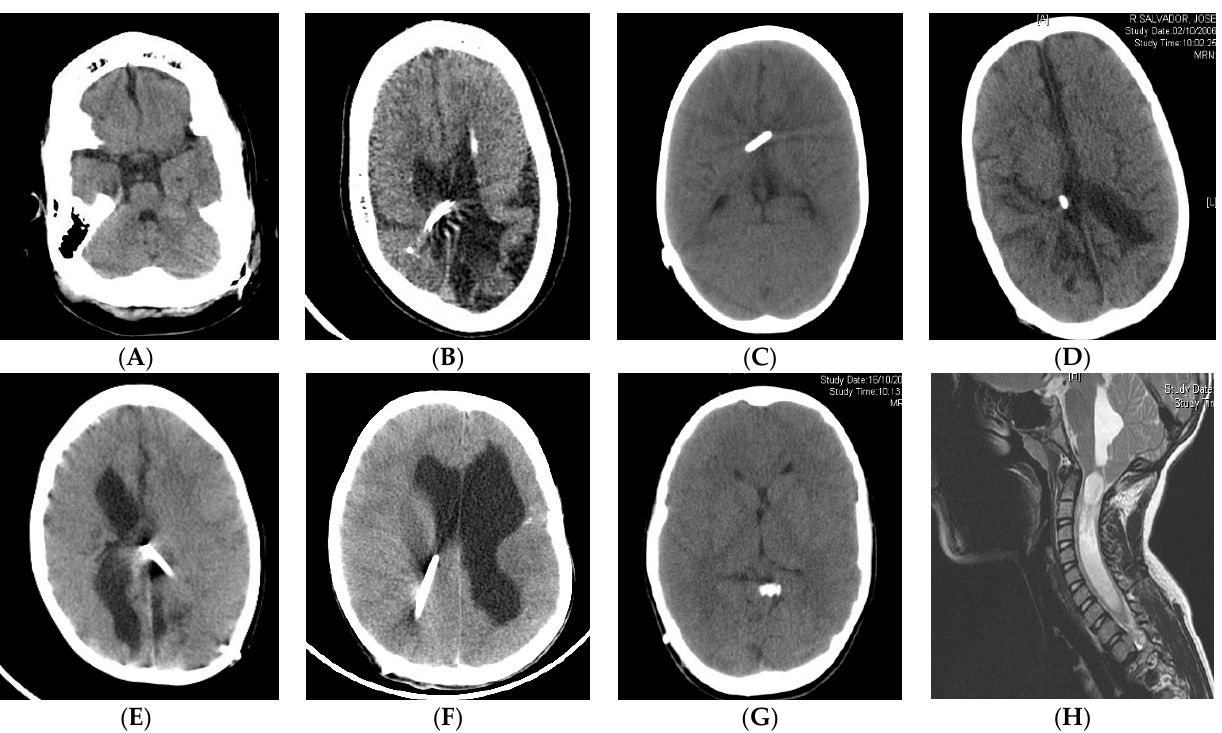
Figure 1. ( A , B ) A 5-year-old patient, shunted at birth after posthemorrhagic hydrocephalus. Postural symptoms. White matter damage with brain atrophy, small non-collapsed ventricles, extra-axial fluid collections, widened brain sulci, calcifications, laminated thickening of the calvarium, dolichocephaly and sinus hyperpneumatization. Shunt exchange with GV implantation was carried out, followed by clinical improvement. ( C ) An 8-year-old, shunted at birth after posthemorrhagic hydrocephalus. Complete ventricular collapse. Clinically, the patient presented sustained intracranial hypertension with papilledema, altered consciousness and bradycardia. Symptoms improved after shunt optimization by implanting an “in line” adjustable valve harboring a flow control device. ( D – F ) Ventricular collapse may be incomplete ( D ), unilateral ( E ) or focal ( F ). Non-collapsed areas may increase in size as a result of CSF isolation ( E , F ) and therefore can be considered for shunt transferring. ( G ) The catheter tip may be located outside the ventricular system (cisterns or extra-axial space). ( H ) Isolated fourth ventricle and syringomyelia as a result of sustained supratentorial overdrainage.